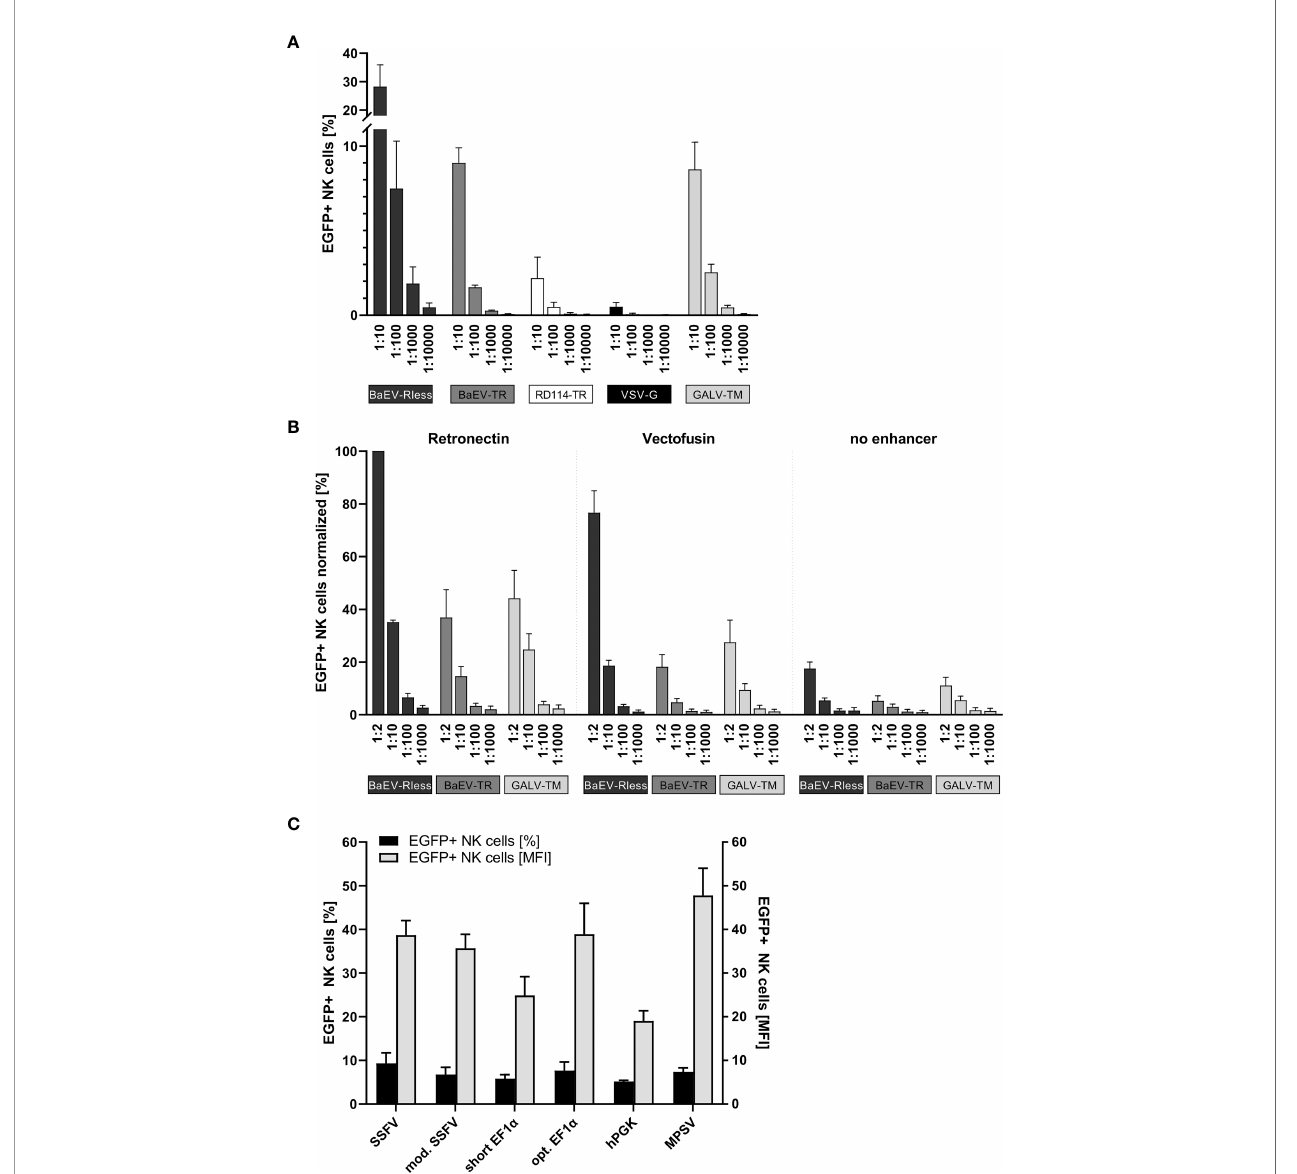
FIGURE 1 | Systematic improvement of primary human NK cell transduction. Primary human NK cells were isolated and cultured as described in the body of the manuscript. (A) After 7 to 10 days of expansion, NK cells were transduced with serial dilutions of EGFP-expressing lentiviral particles pseudotyped with BaEV-Rless, BaEV-TR, RD114-TR, VSV-G, or GALV-TM. Three to four days after transduction, EGFP expression was analyzed by fl ow cytometry. Data are represented as mean ± SEM of four biological replicates. (B) Primary human NK cells were transduced with serial dilutions of EGFP-expressing lentiviral particles pseudotyped with BaEV- Rless, BaEV-TR, or GALV-TM, using Retronectin, Vectofusin, or no transduction enhancer, respectively. Three to four days after transduction, EGFP expression was analyzed by fl ow cytometry. Data are represented as mean ± SEM of fi ve biological replicates. (C) Primary human NK cells were transduced with serial dilutions of lentiviral particles pseudotyped with BaEV-Rless, expressing EGFP under the control of the wild-type or modi fi ed SFFV, the wild-type or optimized EF1 a , the hPGK, or the MPSV promoter. Three to four days after transduction, the expression of EGFP was analyzed. From the serial dilutions, samples with gene transfer rates of between 5% and 10% were analyzed for their EGFP expression intensity [mean fl uorescence intensities (MFIs)]. Data are represented as mean ± SEM of four biological